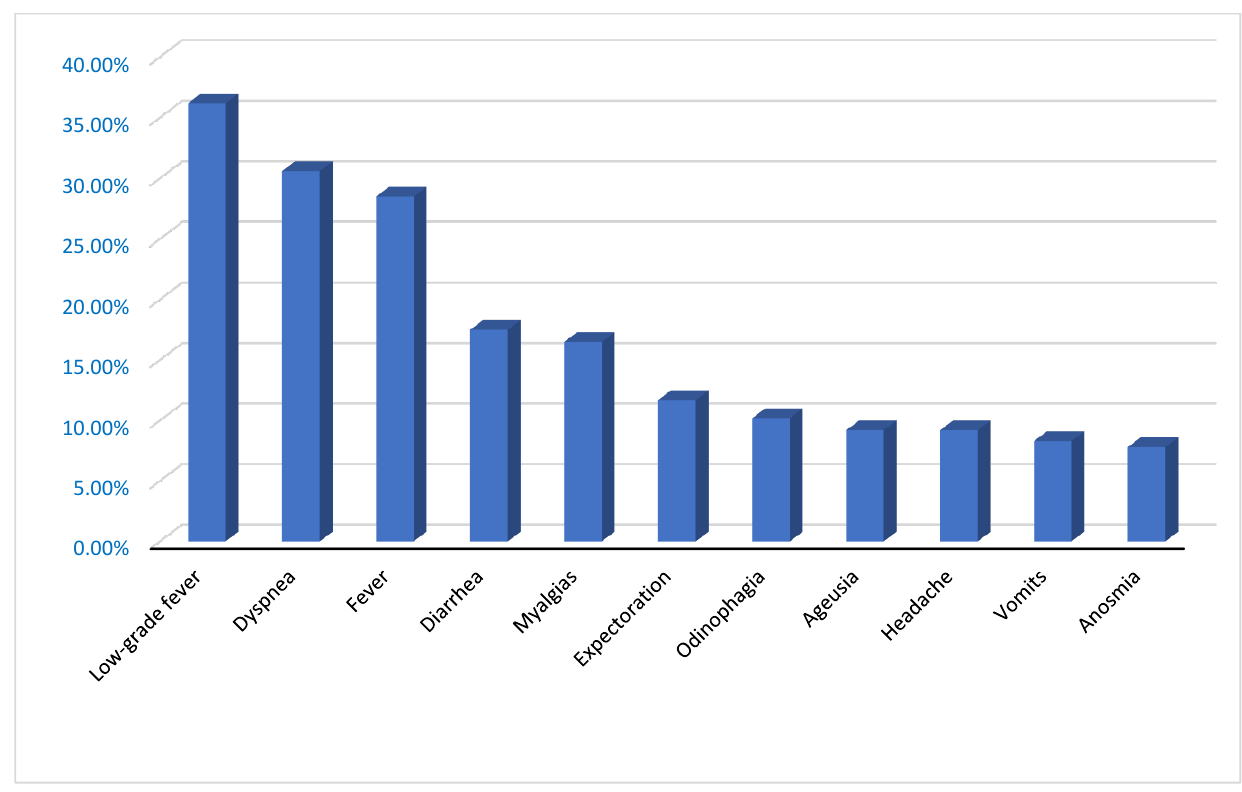
Figure 1. Main symptoms of patients. Table 2. Analysis of lung ultrasound